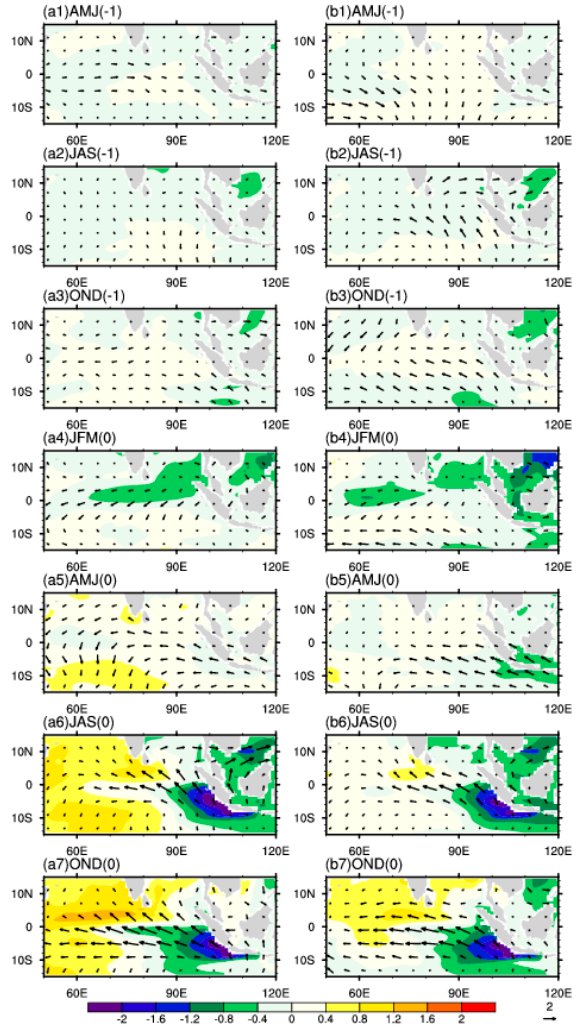
Figure 13. Seasonal evolutions of SSTAs (shaded; units: °C) and related surface wind anomalies (vectors; units: m/s) generated by ( a ) the five pIOD events that occurred with El Niño and ( b ) the five pure IOD events.